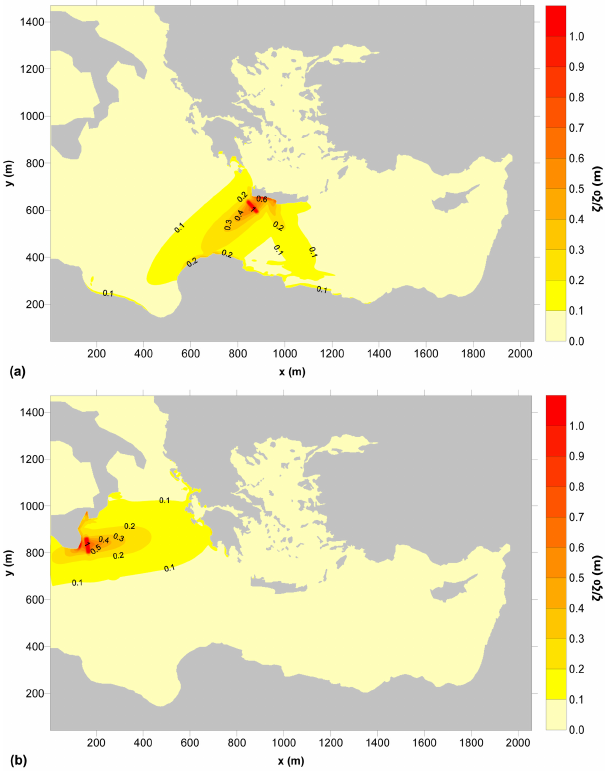
Figure 7. Simulated extreme water elevation ( ζ/ζ 0 ) for the earthquake-induced tsunami scenarios at: (a) the southwest of Crete, and (b) the East of